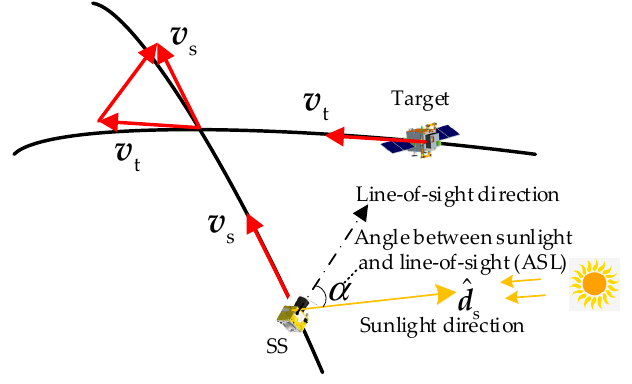
Figure 2. ASL constraints diagram.